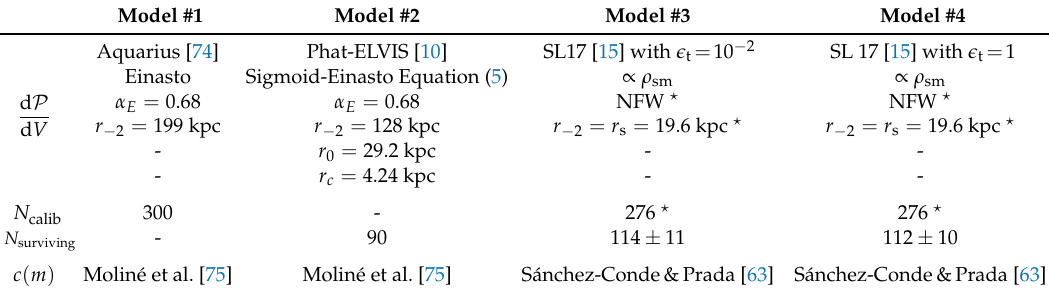
Table 1. Subhalo parameters for the models investigated in this study, with model #1 based on results of DM-only numerical simulations, while models #2 to #4 are different implementations of DM subhalos post-processed in the Milky Way halo and baryonic disk potential. For models #2, #3, and #4, we also show the number of surviving subhalos with tidal masses between 10 8 M for details and parameters common to all subhalo